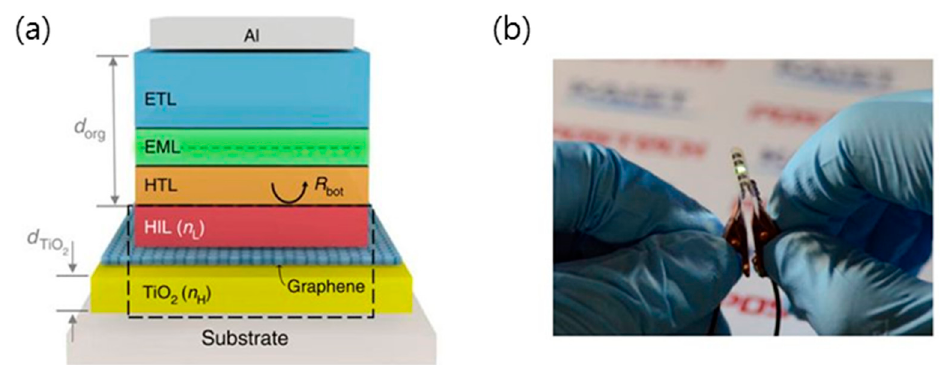
Figure 13. ( a ) Schematic device structure of the proposed flexible TiO2/graphene Organic light- emitting diodes (OLEDs). ( b ) Photograph of the proposed OLEDs in operation. Reproduced with the permission of Reference [139]. Copyright 2016, Nature Publishing Group.